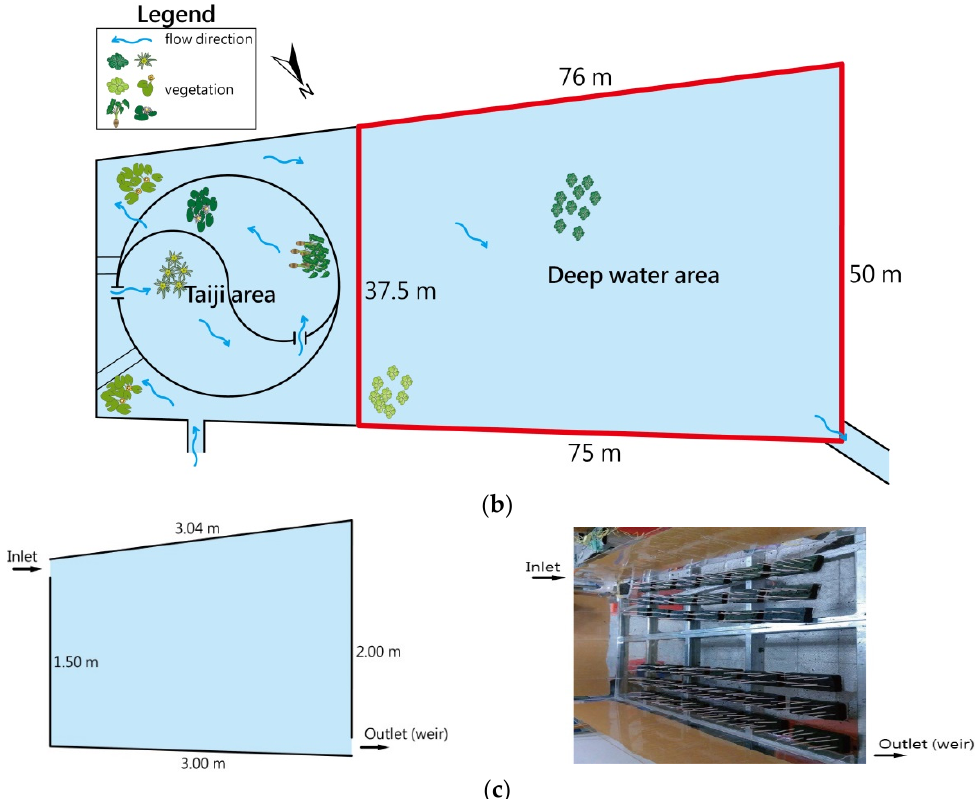
Figure 1. ( a ) Study area location in Taoyuan County, Northern Taiwan; ( b ) farm pond (prototype) with dimensions of 50 m wide by 75 m long. The vegetation in the wetland consists of dominant emergent vegetation such as Cyperus papyrus and Cyperus malaccensis Lam. subsp. monophyllus and minor floating vegetation, such as Nuphar shimadai ; and ( c ) flume model of the deep area (2 m wide by 3 m long) viewed from above ( left ) and a photograph of the flume and the distribution of the installed obstructions in a perspective view from the outlet ( right ).